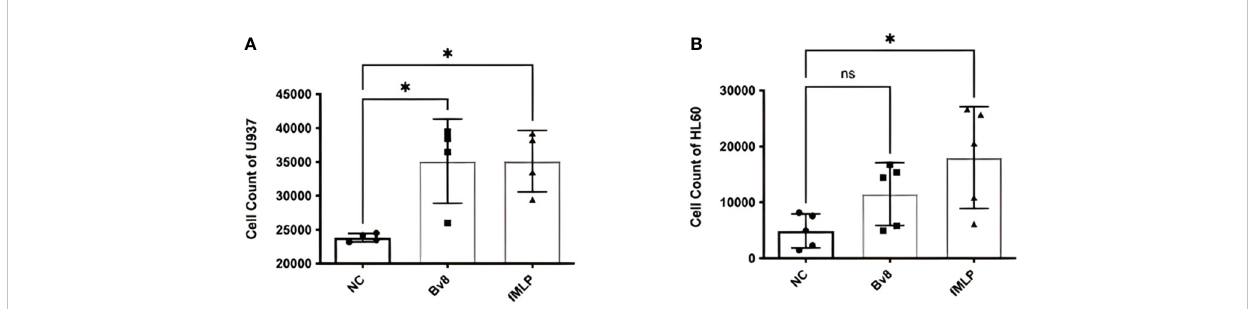
FIGURE 2 Chemotactic effects of Bv8 on myeloid cell lines. (A) The number of recruited U937 (n=4) cells moving towards Bv8 (10 µM) or fMLP (10 µM) was assessed by transwell migration assay. (B) The number of recruited HL60 cells (n=5) cells moving towards Bv8 or fMLP. All data were presented as mean ± SD. Mann-Whitney U test followed by Dunn ’ s test was used for statistical analysis. *p<0.05, ns, not signi fi cant. n refers to the number of independent